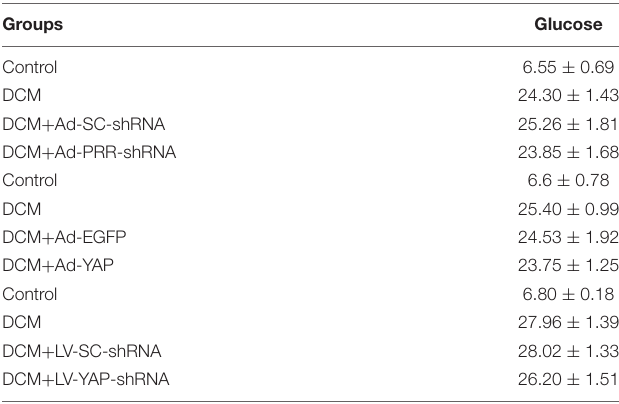
TABLE 1 | Blood glucose in three separate experiments in rats.